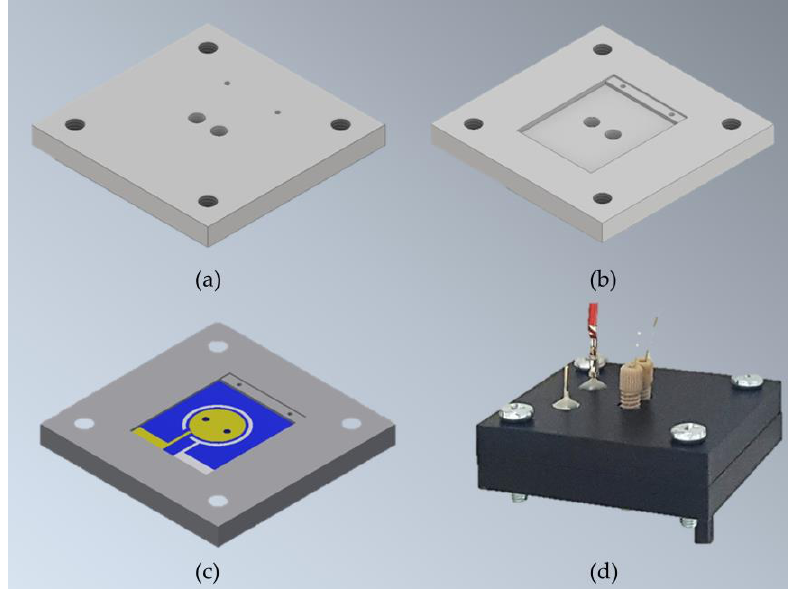
Figure 4. Schematic µMFC holder design and assembled µMFC: The holder is composed of two identical pieces of homoacetal polymer designed to house electrodes and permit fluidic and electrical connections. ( a ) Outer view of the holder piece; ( b ) inner view of the holder piece; ( c ) inner view of the holder piece; ( c ) holder inner view housing one of the electrodes; ( d ) assembled µMFC with microfluidic and electrical connections.